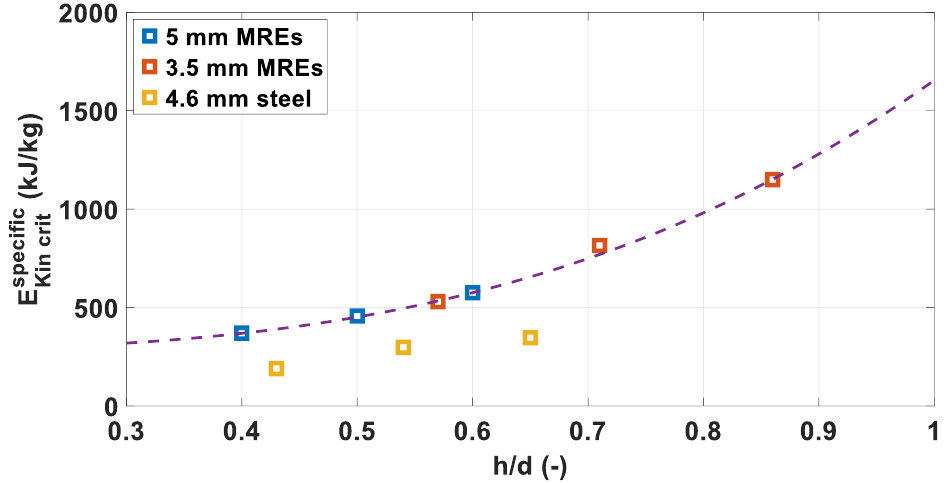
Figure 7. Specific Critical Impact Energies over normalised plate thickness. The dashed line indicates the kinetic energy per unit mass.